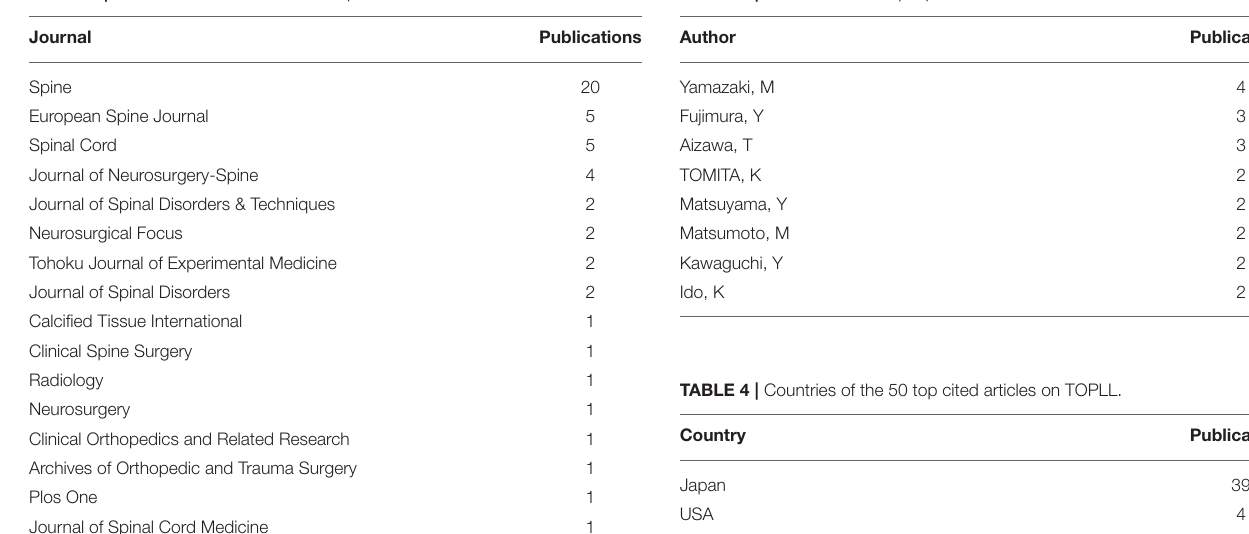
TABLE 2 | Journal distribution of the 50 top cited articles on TOPLL.